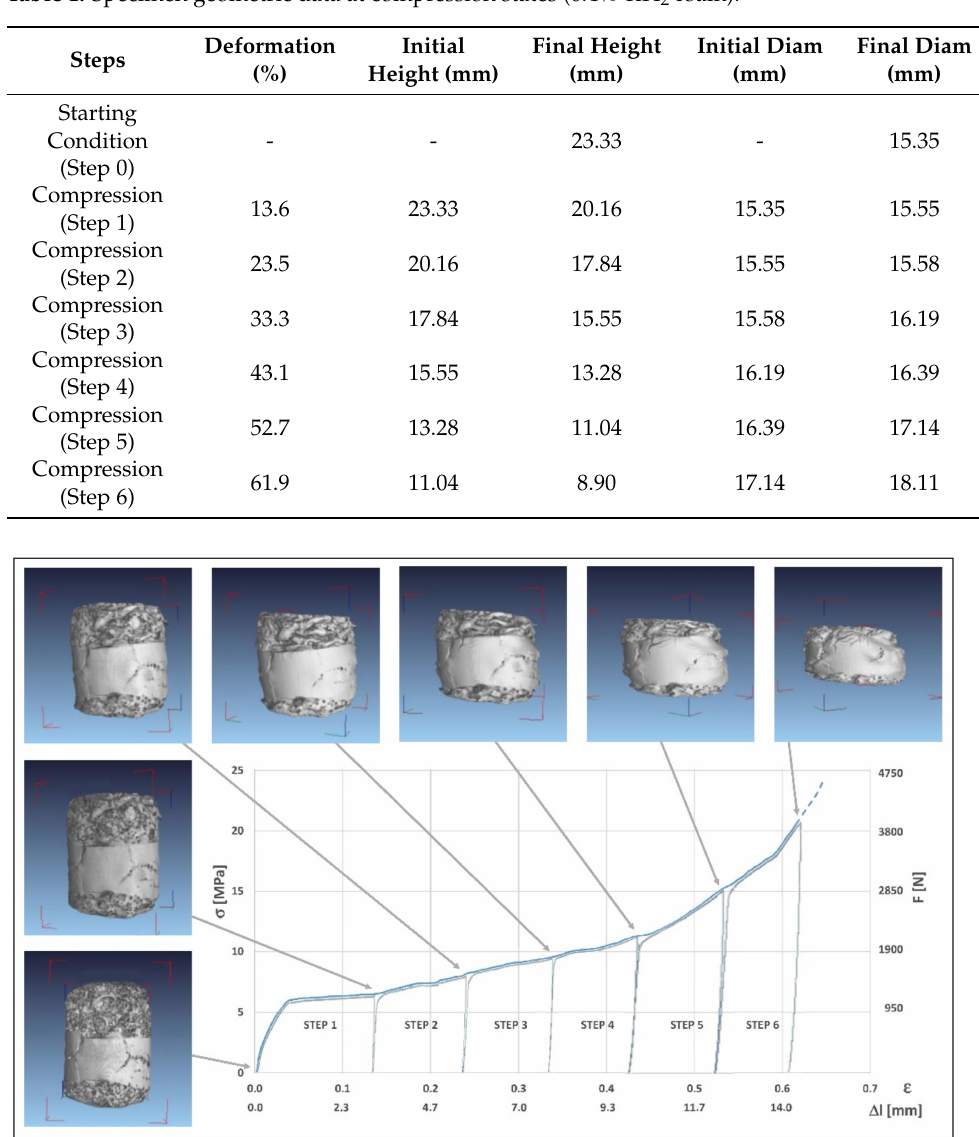
Figure 6. Results of compression test (0.4% TiH 2 foam): sequence of loading curves, final state for each step of compression (CT rendering), overall stress–strain